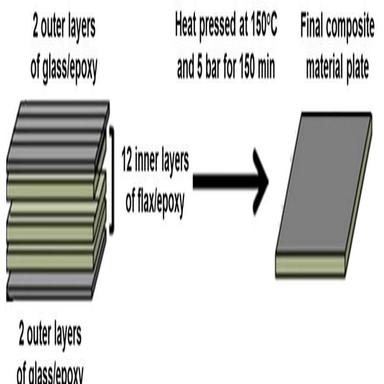
Compression molding process for fabricating the novel "sandwich structure" of Type A and B versions of the current glass/flax/epoxy composite material.